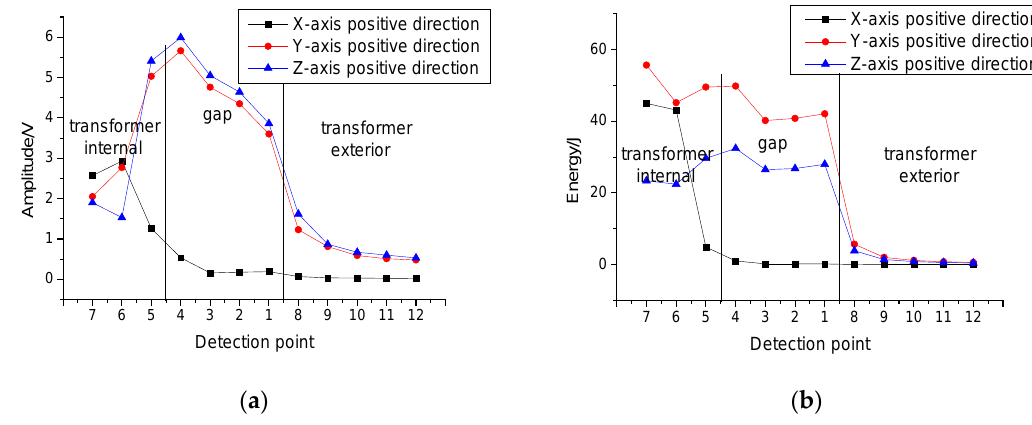
Figure 9. Radiation pattern of monopole antenna: ( a ) Radiation pattern ( φ = 0 ◦ ); ( b ) Radiation pattern ( θ = 0 ◦ ).